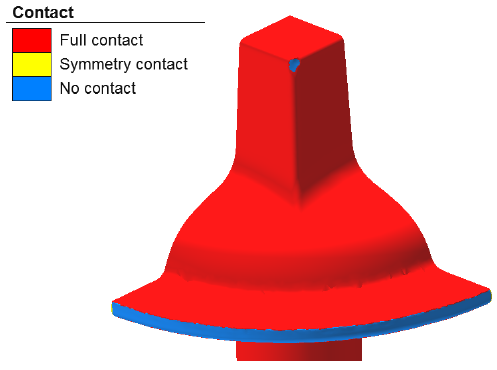
Figure 3. Screw spike with a vertex underfill for 2.25 mm burr cannel.